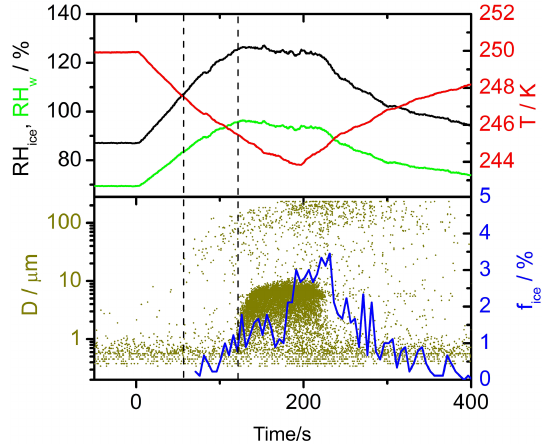
Figure E2. Ice nucleation characteristics of pre-activated CID parti- cles during expansion cooling. The data types are the same as shown in Fig.